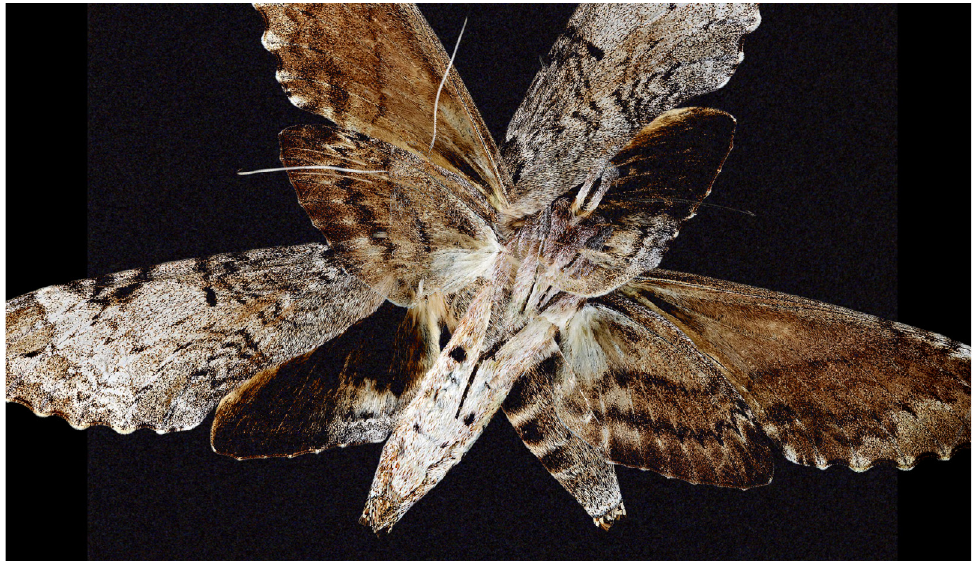
Fig. 5 – Still from Pseudosphynx (2020). Courtesy of the